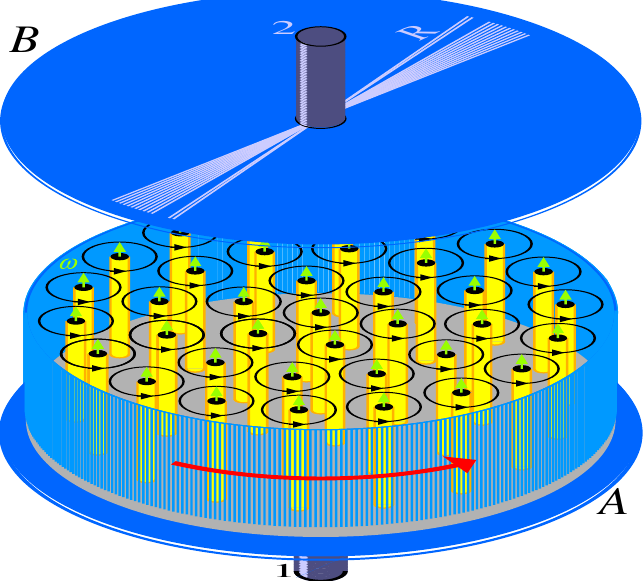
Figure 15. The rotating disk A involves the driven disk B to rotation by grabbing it through the vortex filaments (drawn by yellow cylinders) growing from the bottom drive disk [131]. Green arrows represent the vorticity (cid:126) ω black circles with arrows depict vortex rotation of the yellow cylinders. The both have radius R impaled on unbound axes 1, and